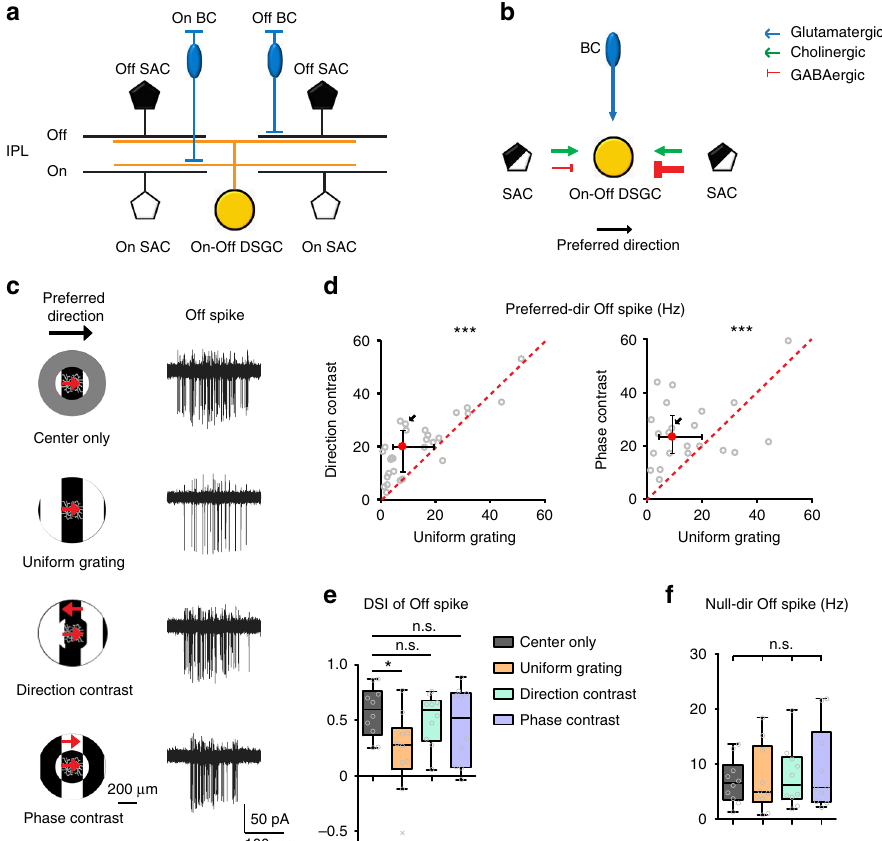
Fig. 1 pDSGC Off responses are contextually modulated. a Schematic shows side view of the laminar organization of bipolar cells (BCs), SACs and On-Off DSGCs in the inner plexiform layer (IPL). b Simpli fi ed schematic shows major types of synaptic inputs onto On-Off DSGCs. c Left: Schematics show the visual stimulus conditions. A schematic of a pDSGC is shown in the center of each stimulus to indicate the relative sizes of DSGC dendritic arbors and visual stimuli. The red arrows indicate the moving directions of the drifting gratings, and the black arrow at the top indicates the preferred direction of the pDSGC. Right: Example Off spike traces of a pDSGC from a control mouse evoked by the stimuli on the left. Spike traces are overlays of 10 grating cycles (also see Methods) for this and subsequent fi gures. d Scatter plots compare Off fi ring rate during uniform versus compound gratings. Direction-contrast vs uniform grating: n = 29 cells from 13 mice; phase-contrast vs uniform grating: n = 22 cells from 9 mice. Wilcoxon signed-rank test, *** p < 0.001. Grey dots represent individual cells, red dots with error bars indicate the median ± IQR, and diagonal red dashed lines are unity lines. The data point corresponding to the example traces was labelled by the black arrow. e Direction selectivity index (DSI) of pDSGC Off spiking in different stimulus contexts. Friedman test: n = 10 cells from 4 mice, * p = 0.025. Wilcoxon signed-rank test with Bonferroni correction: center only vs uniform grating: * p = 0.0039; center only vs direction-contrast: p = 0.23; center only vs phase-contrast: p = 0.70. Box plots represent minimum/ fi rst quartile/median/third quartile/maximum values, open grey dots represent individual cells, grey crosses are outliers de fi ned by Tukey ’ s fences. f pDSGC Off fi ring rate when center gratings drift in the null direction. Friedman test: n = 10 cells from 4 mice, p = 0.29. See also Supplementary Fig. 1 for further identi fi cation of Off fi ring rate during